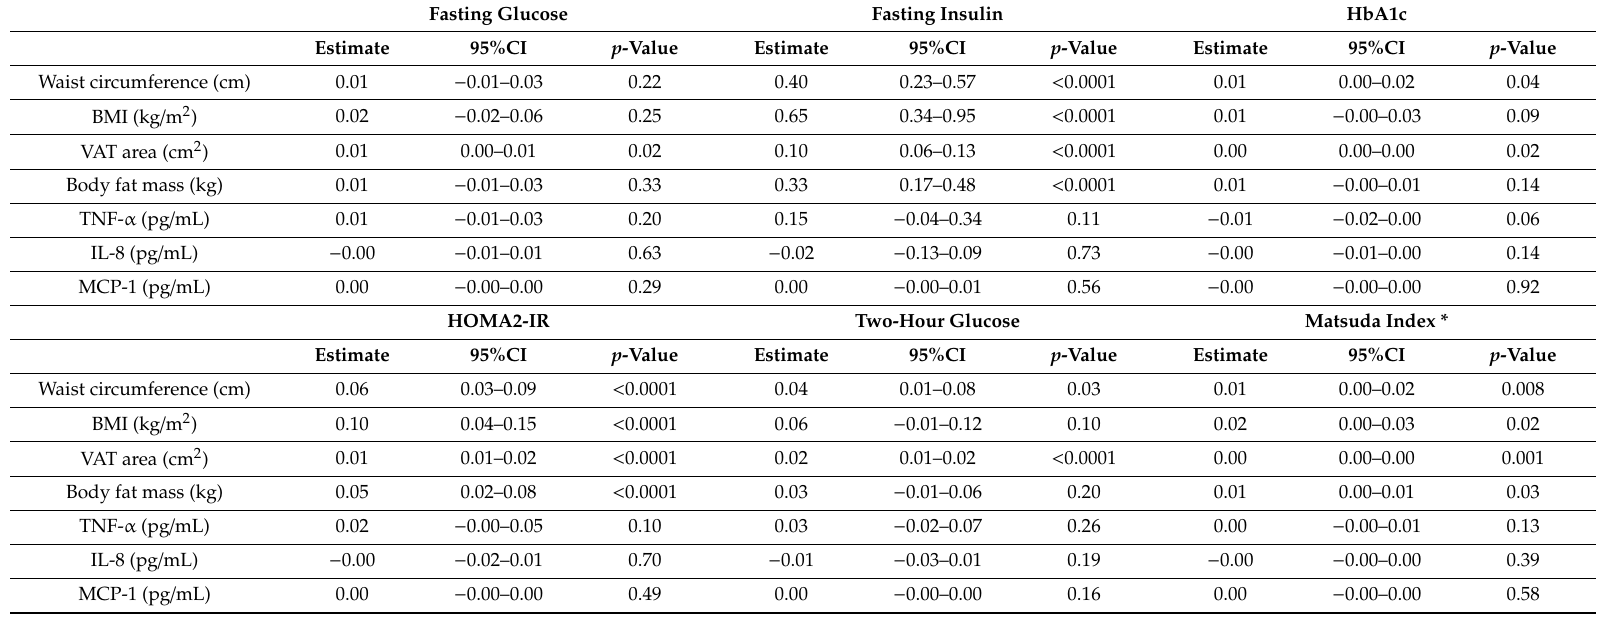
Table 5. Regression coe ffi cients (95% CIs) for the associations between body composition and inflammatory cytokines and markers of T2D risk in black SA women. Fasting Glucose Fasting Insulin HbA1c Estimate 95%CI p -Value Estimate Estimate